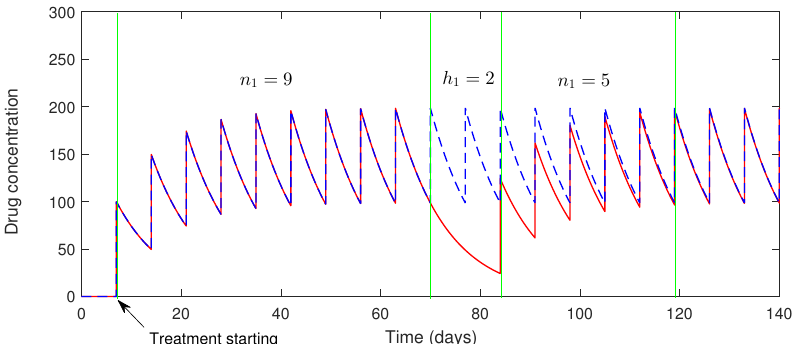
Figure 9. Dynamics of the drug with and without drug holidays, taking an impulse interval of ( τ = 7 days) and a fixed drug dosing of ω = 100 mg with two consecutive drug holidays, h 1 =